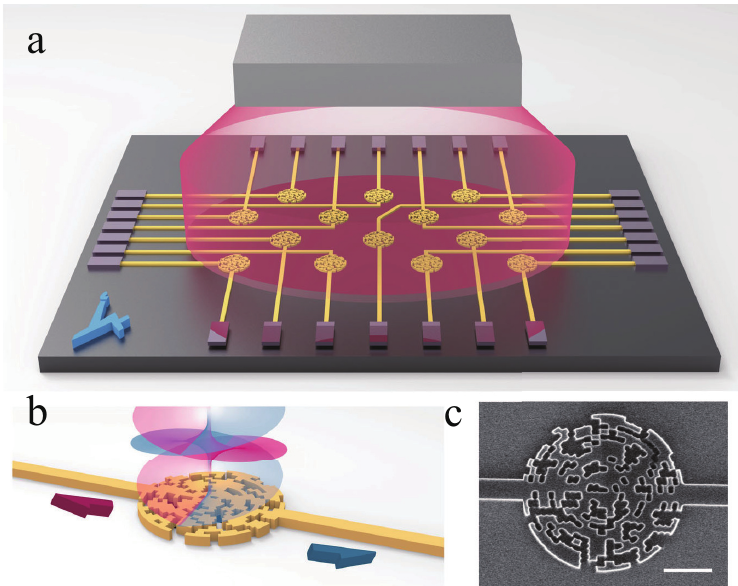
Figure 12. ( a ) Conceptual sketch of integrated magnetic sensor array; ( b ) schematic illustration showing the operation of spin selector; ( c ) scanning electron microscope(SEM) of the fabricated device